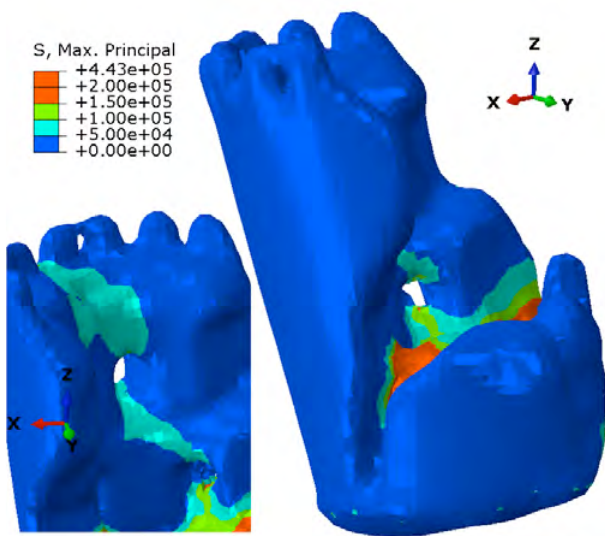
Figure 8. Tensile principal stress contour plot of the